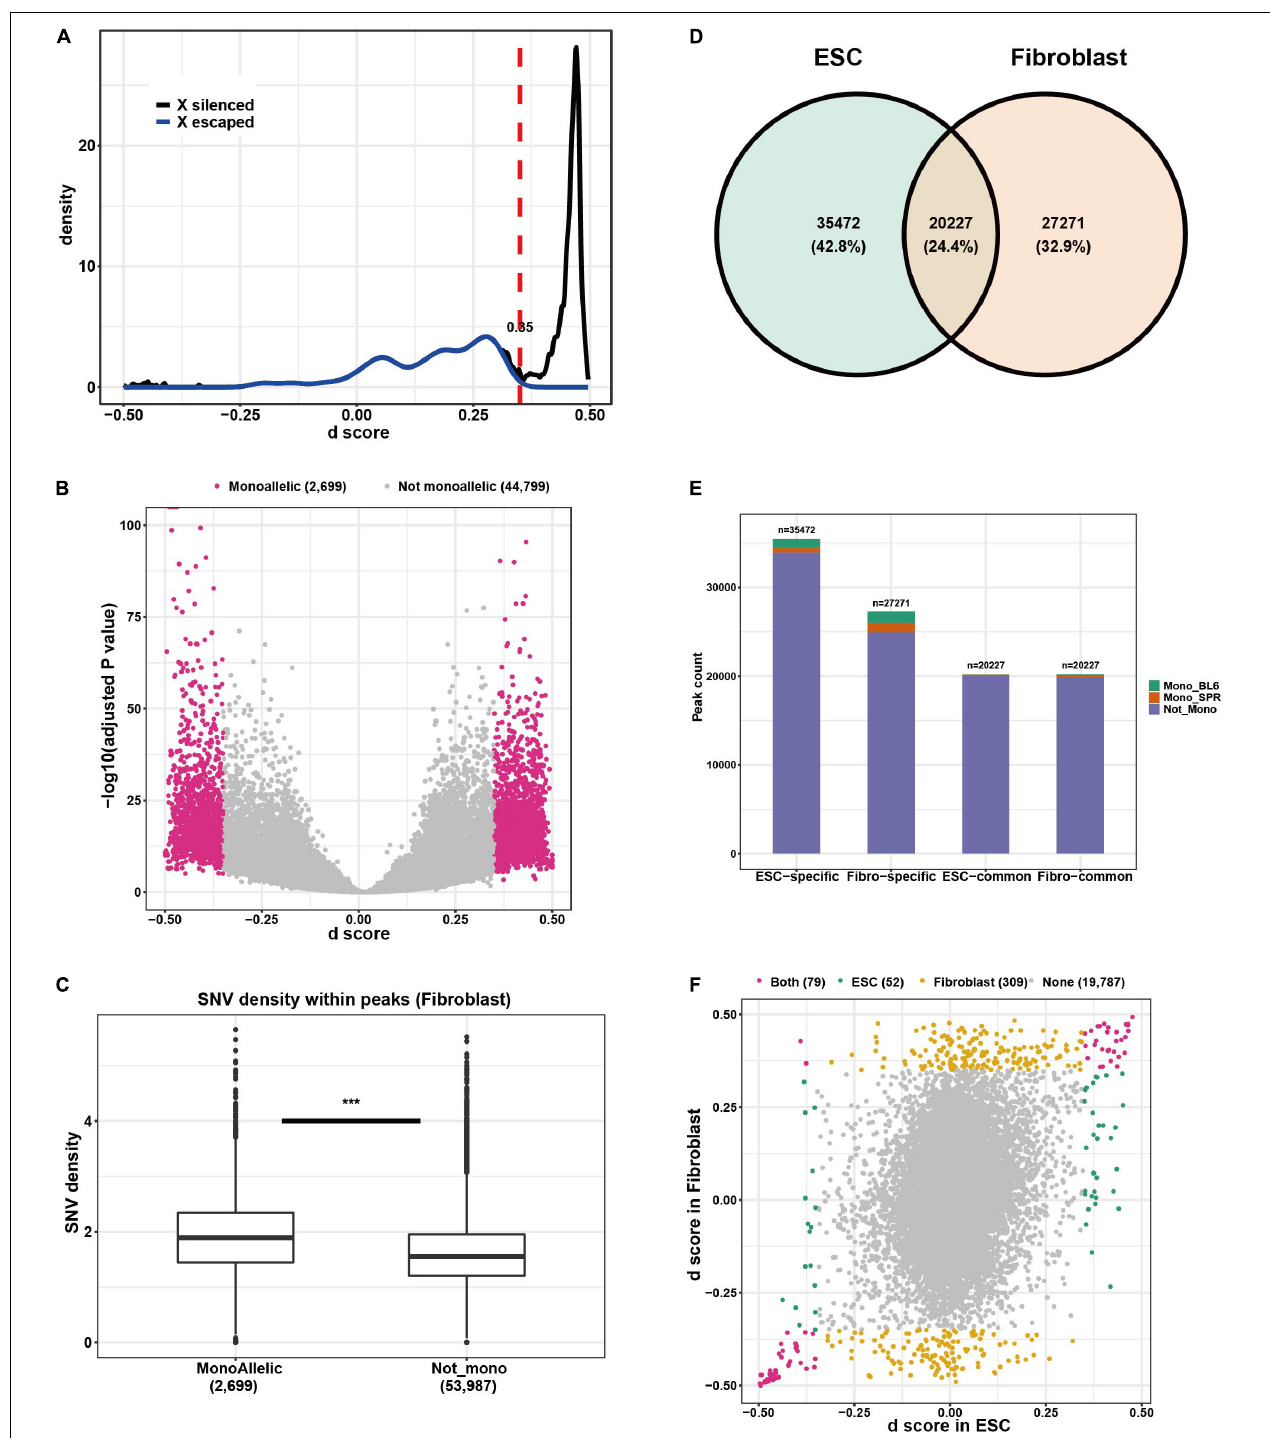
FIGURE 3 | Quantification of allelic chromatin accessibility in ESCs and fibroblasts and cell-type dependent patterns. (A) d score of X-chromosome peaks in fibroblast. The blue line describes the distribution of d score of X-escaped peaks, black line indicates the d score distribution of X-silenced peaks. (B) Monoallelic peaks detected in fibroblast cells. (C) SNV density comparison between monoallelic peaks and non-monoallelic peaks. (D) Overlapped peaks between ESC and fibroblast. (E) Monoallelic peaks in cell type specific peaks and in peaks shared by the two cell types. (F) Cell type-dependent patterns of monoallelic peaks.